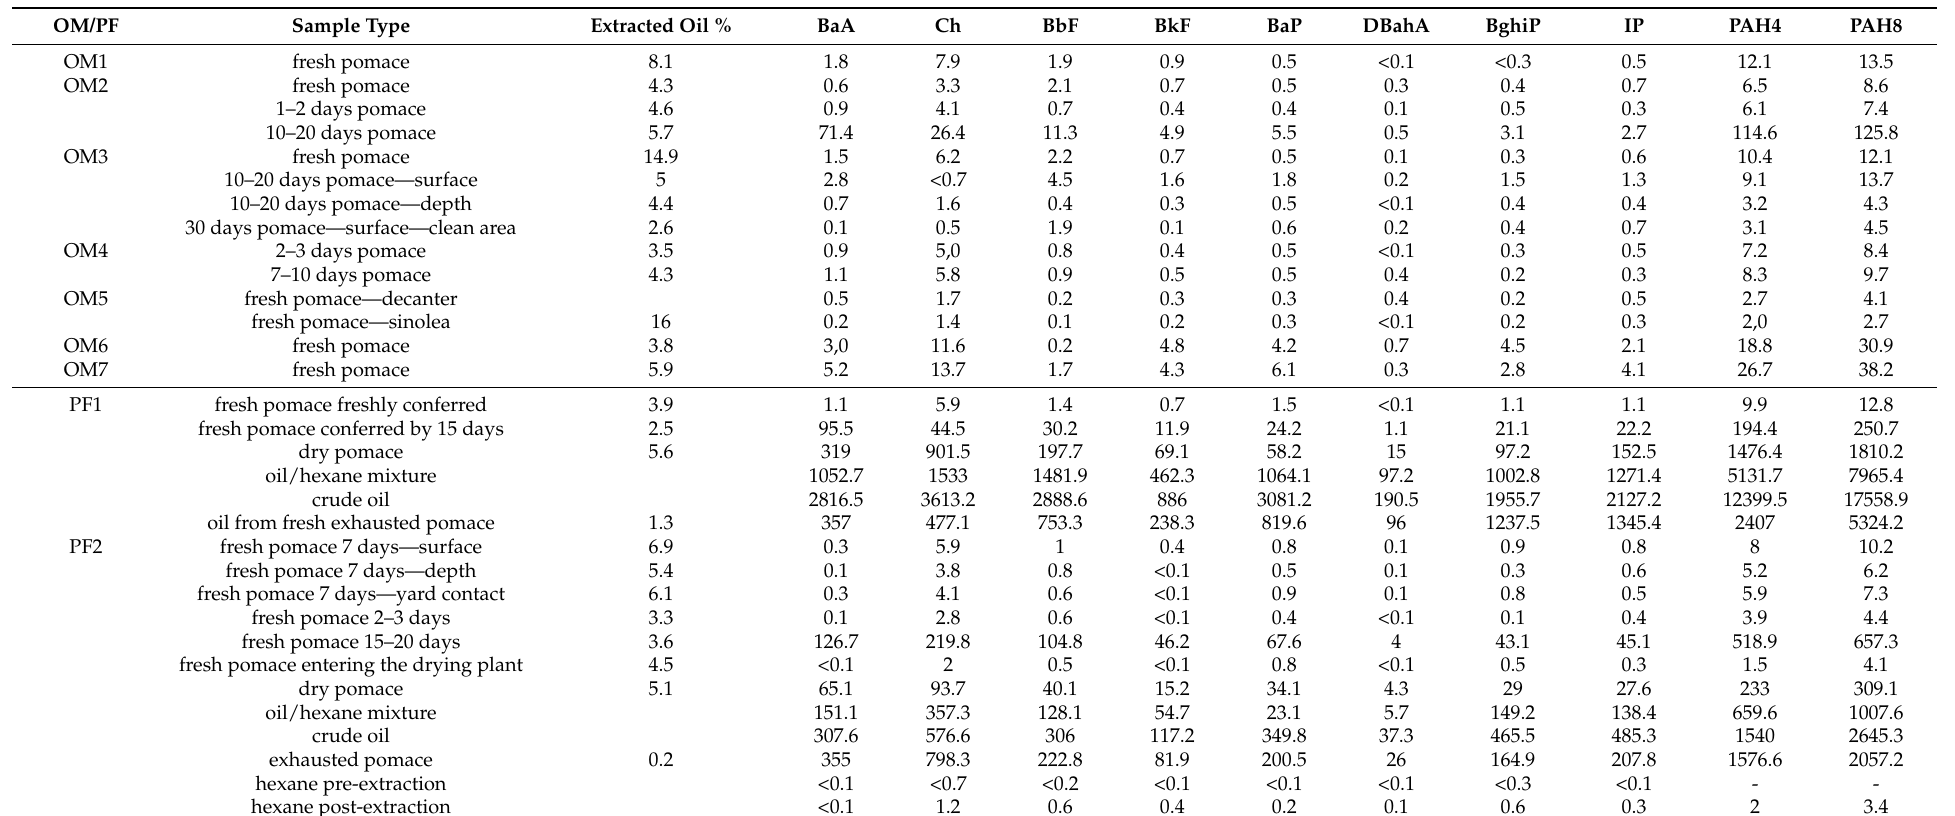
Table 4. Heavy PAHs content, expressed as µ g/kg, in pomace samples collected in different olive mills (OM) and pomace factories